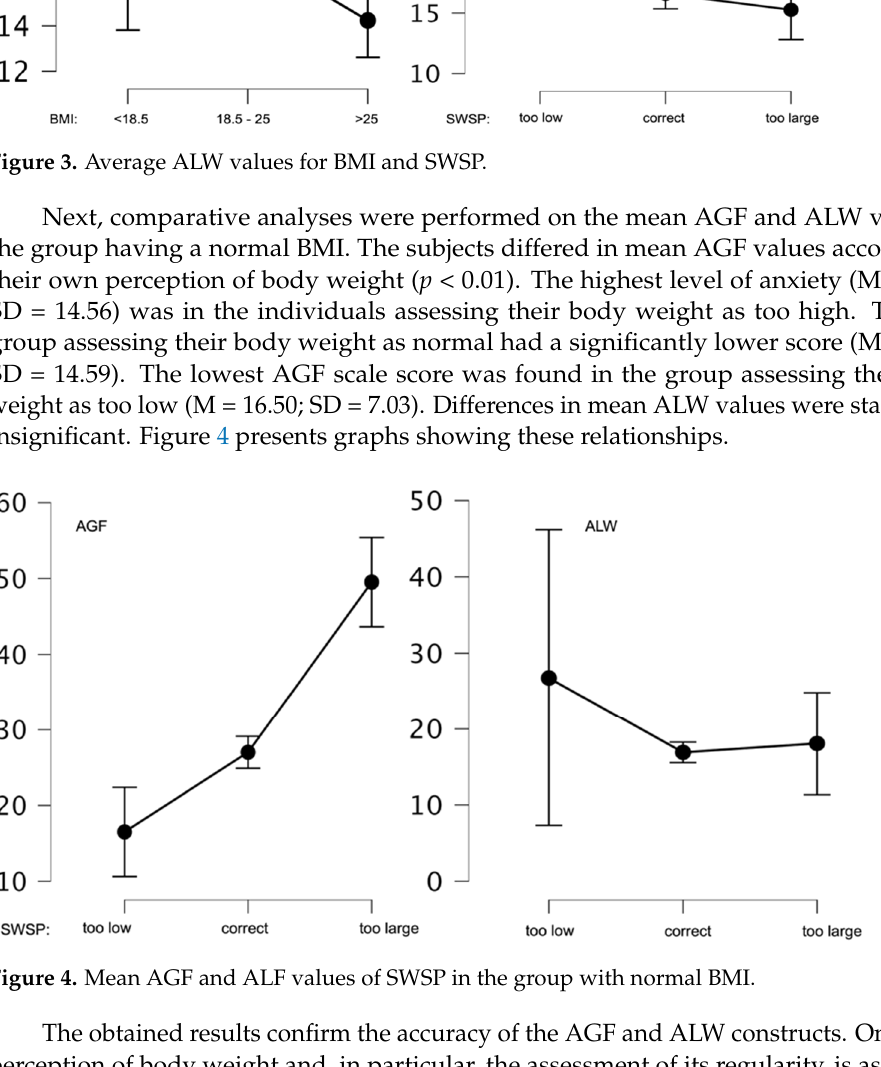
Figure 3. Average ALW values for BMI and SWSP.